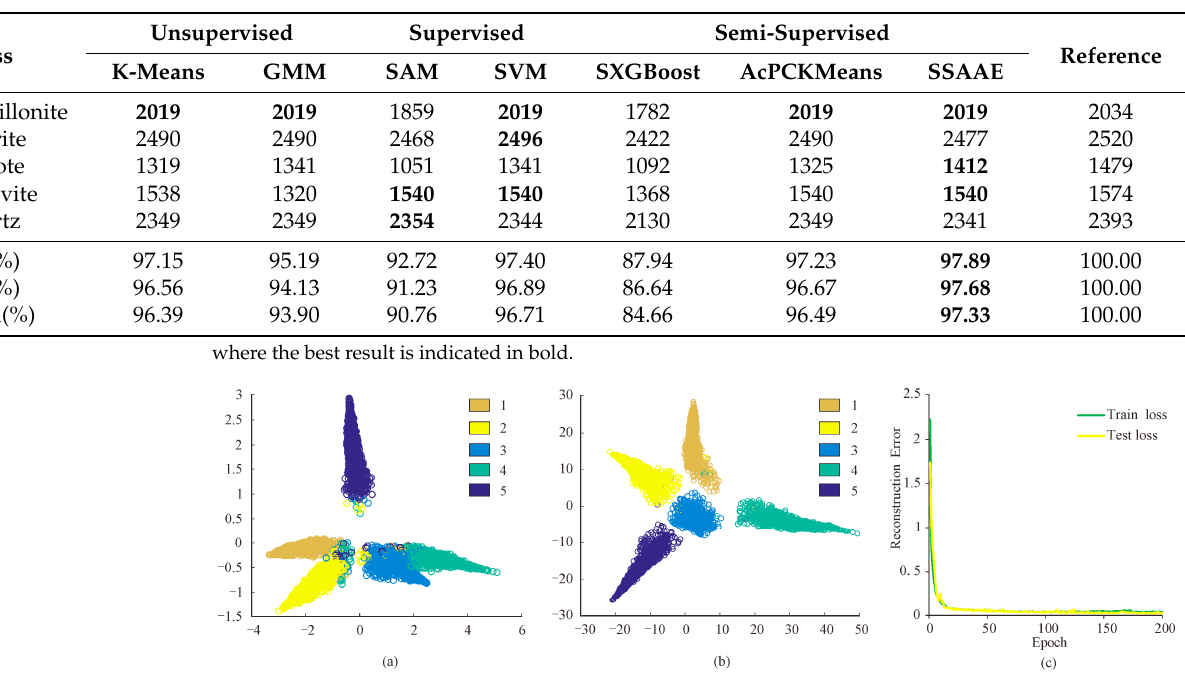
Figure 9. Maps of spectral absorption features and their correspondence to latent features. ( a ) The absorption features of the 40th mixed data at the wavelength range of 2100–2430 nm; ( b ) the corre- spondence between absorption depth (Dep2340) and the 6th latent feature (Z6); ( c ) the correspond- ence between absorption area (AA2340) and the 10th latent feature (Z10); ( d ) the correspondence between absorption symmetry and the 8th latent feature (Z8).